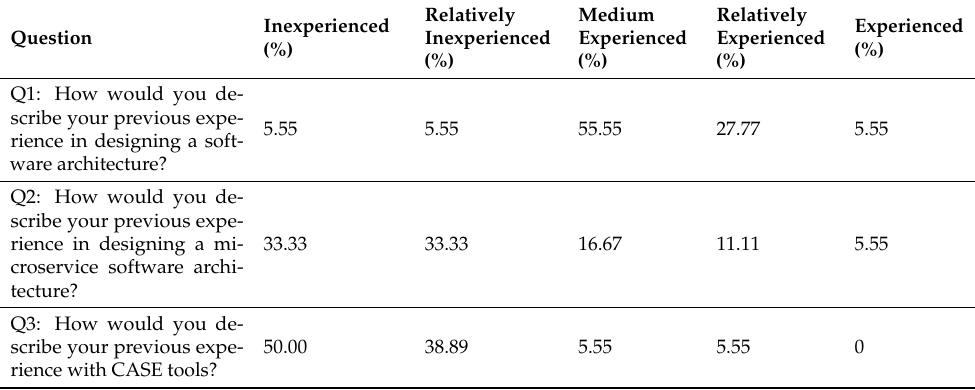
Table 14. Percentages of responses (n = 18) for Experience group of